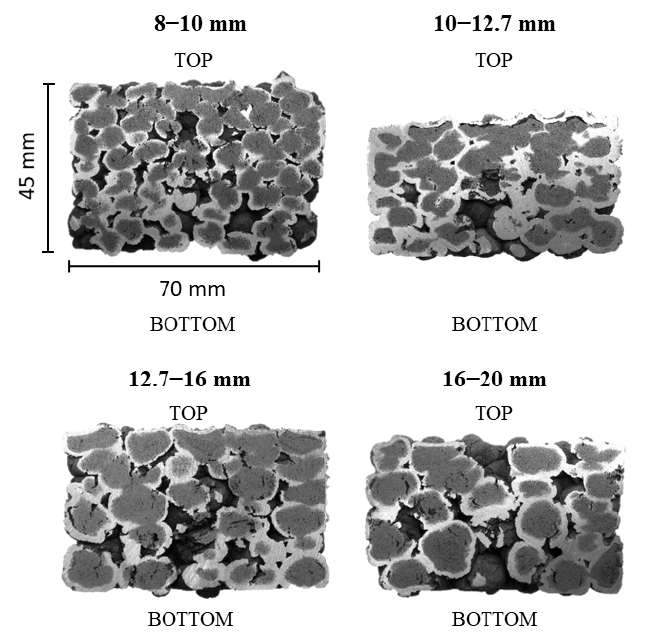
Figure 10. Digital images of cross sections of the samples after the reduction-softening tests. The final temperatures of the tests were 1173 °C, 1227 °C, 1179 °C and 1175 °C for pellets sized 8–10 mm, 10–12.7 mm, 12.7–16 mm and 16–20 mm, respectively.